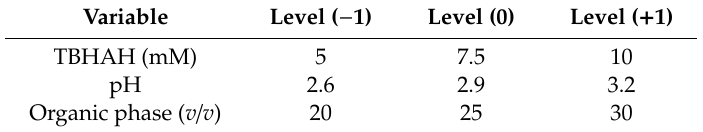
Table 3. Real and coded values of variables considered in design of experiment.